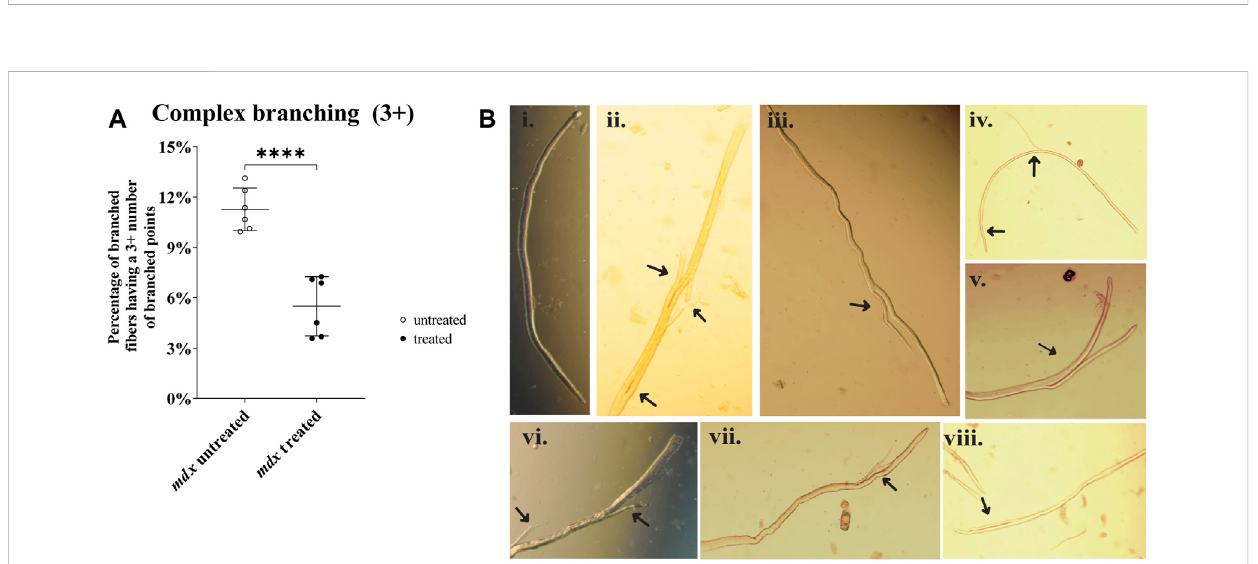
FIGURE 4 Enzymatically digested mdx EDL muscle fi bers. (A) Scatterplots of complex fi ber branching (3 +) between mdx untreated and mdx NAC treated (P= < 0.0001). Fibers from LC were omitted due to no presence of fi ber branching. Data shown in both graphs are mean ± SD. Statistical differences displayed in graph are assessed by unpaired t -test with signi fi cance established at p < 0.05 (B) Photomicrographs (X200) of enzymatically digested EDL muscle fi bers (note in some cases the whole fi ber is not shown.) a selection of NAC treated and untreated mdx are shown in (Bi-viii) (Bi) a straight mdx fi ber with no branching. (Bii) : is a fi ber with 3 branches (Biii,v,vii) : fi bers with one branch (Biv,vi) fi bers with 2 small branches (Bviii) : fi ber has a split that is connected to the main (i,iii,iv,v,vii) are from mdx NAC; (ii,vi,viii) are from mdx untreated